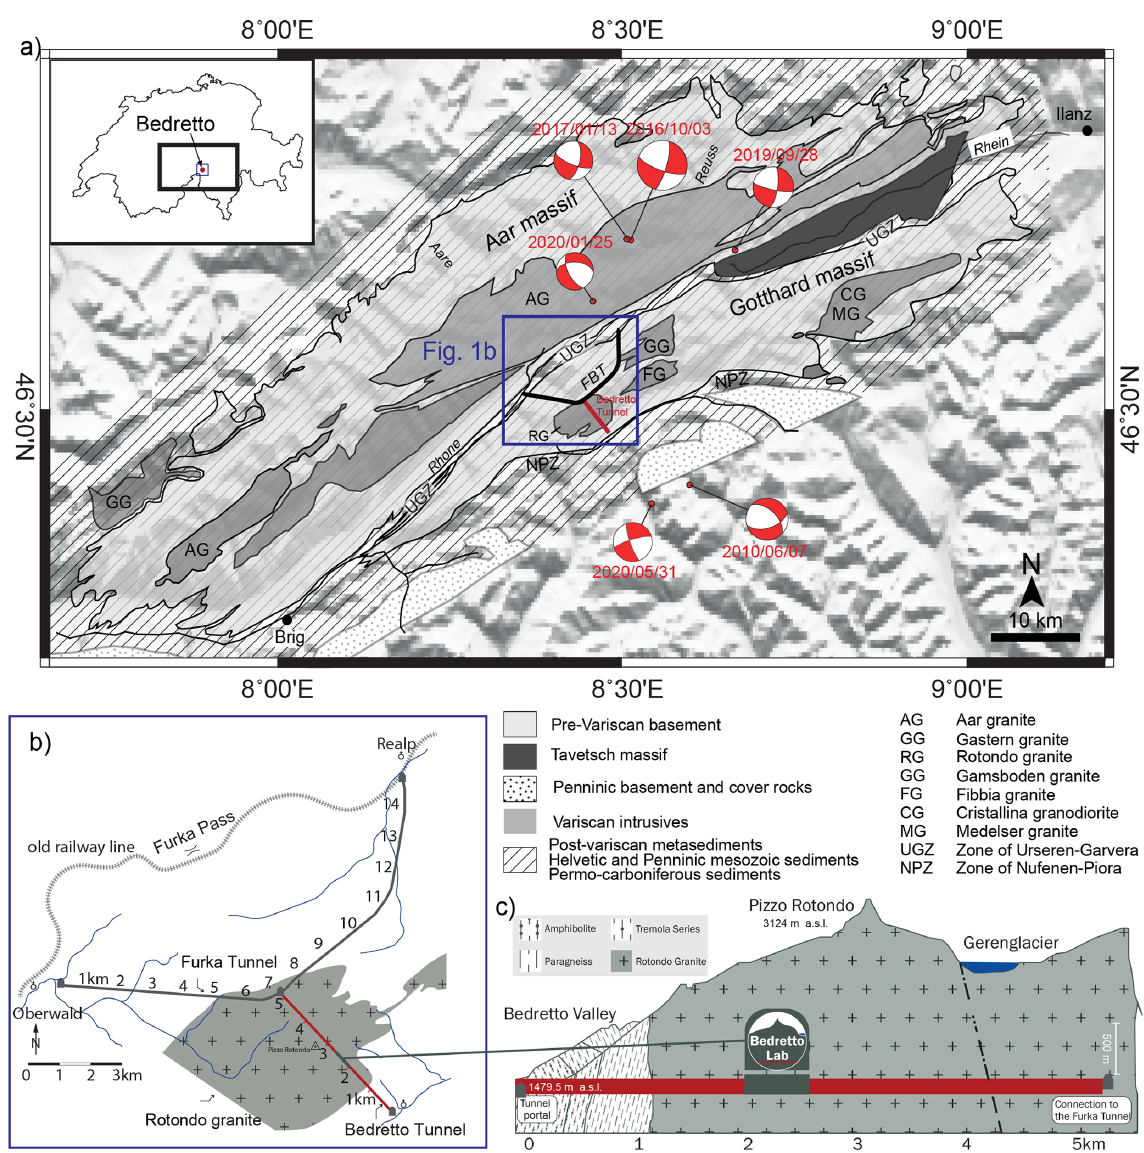
Figure 1. (a) Integrated geological, topographical and seismological information near the Aar and Gotthard massifs surrounding the Bedret- toLab (Keller and Schneider, 1982; adapted from Lützenkirchen and Loew, 2011, and Gischig et al., 2020). (b) Map view of the Bedretto Tunnel and the hosting Rotondo granite. (c) Cross-sectional view of the BedrettoLab with respect to the